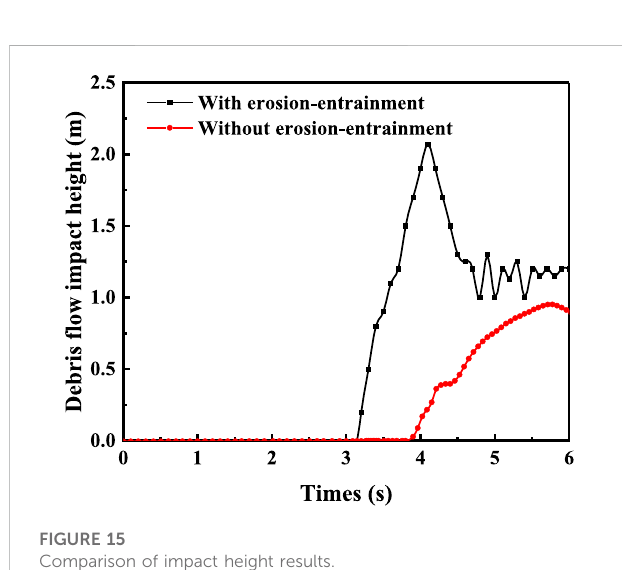
FIGURE 15 Comparison of impact height results.